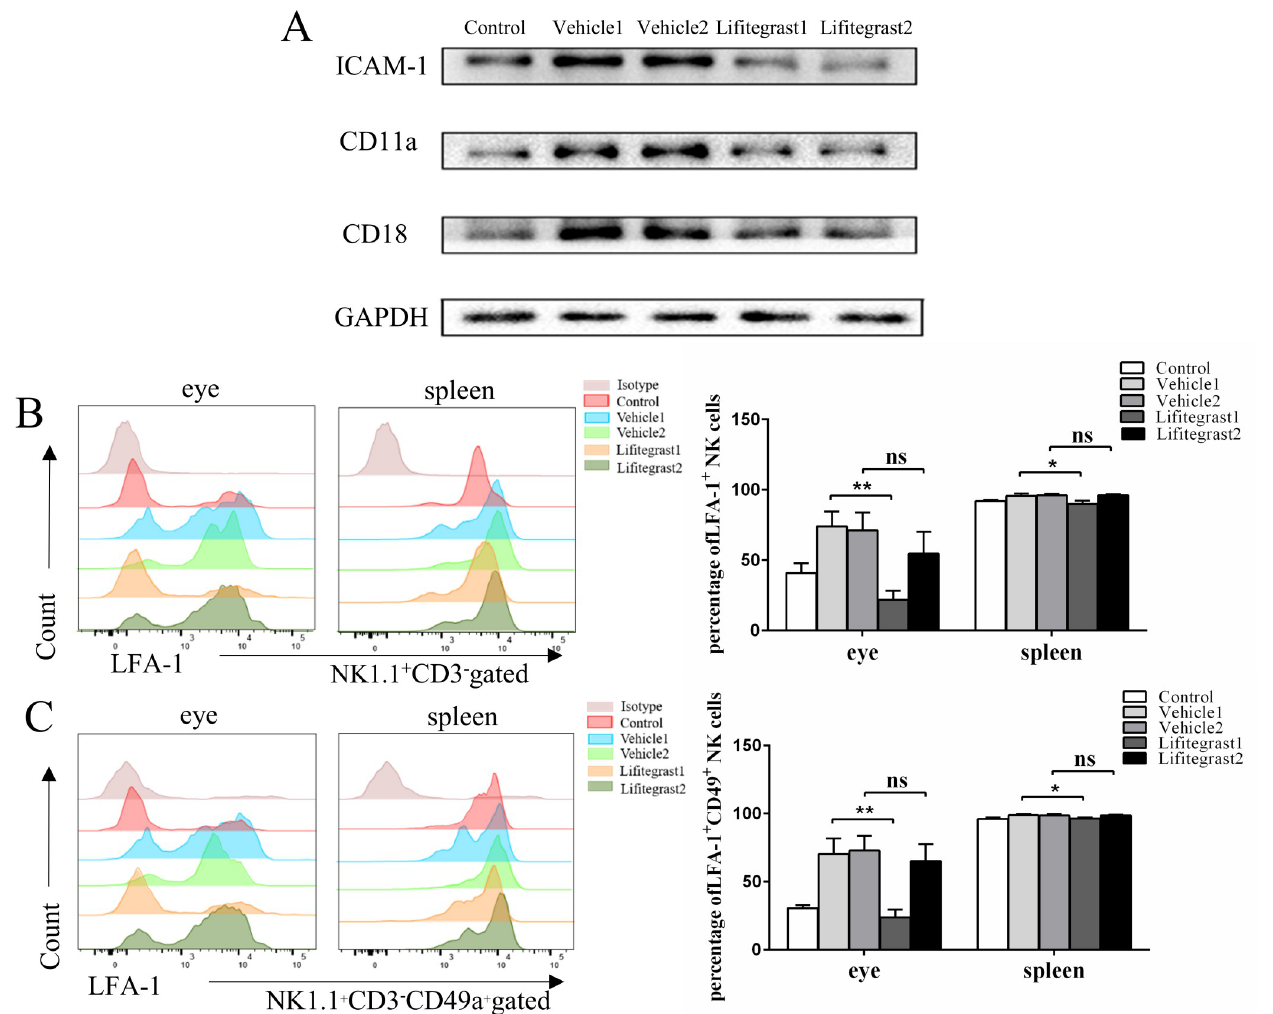
Fig 6. Topical lifitegrast administration inhibited the expression of LFA-1 and ICAM-1 in OT murine model. (A) Western blot analysis showed that ICAM-1 and LFA-1 were decreased in infected eyes after lifitegrast treatment. GAPDH was used as an internal control and the results are from a pool of protein from two mice. Flow cytometry analysis of LFA-1 expression in CD3 - NK1.1 + cells (B) and CD49a + NK cells (C) from lifitegrast-treated eyes or spleen of OT murine model. Pools of 10 mice and the experiment was repeated three times. The differences from the groups were compared using an ANOVA test. ns, not significant; � p < 0.05; �� p <